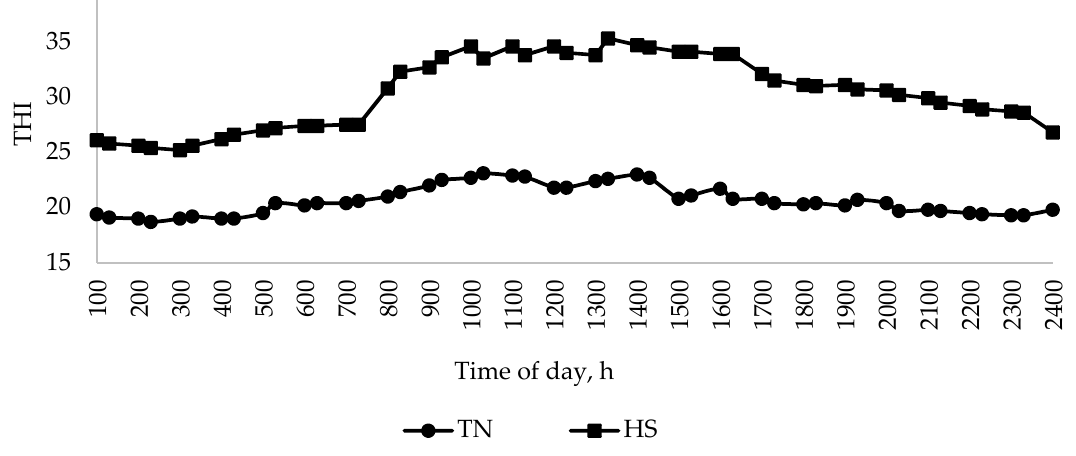
Figure 1. Mean temperature–humidity index (THI) over 24 h in thermoneutral (TN) and heat stress (HS) rooms, over the 14-d period of the experiment. Data are pooled for each replicate ( n = 56